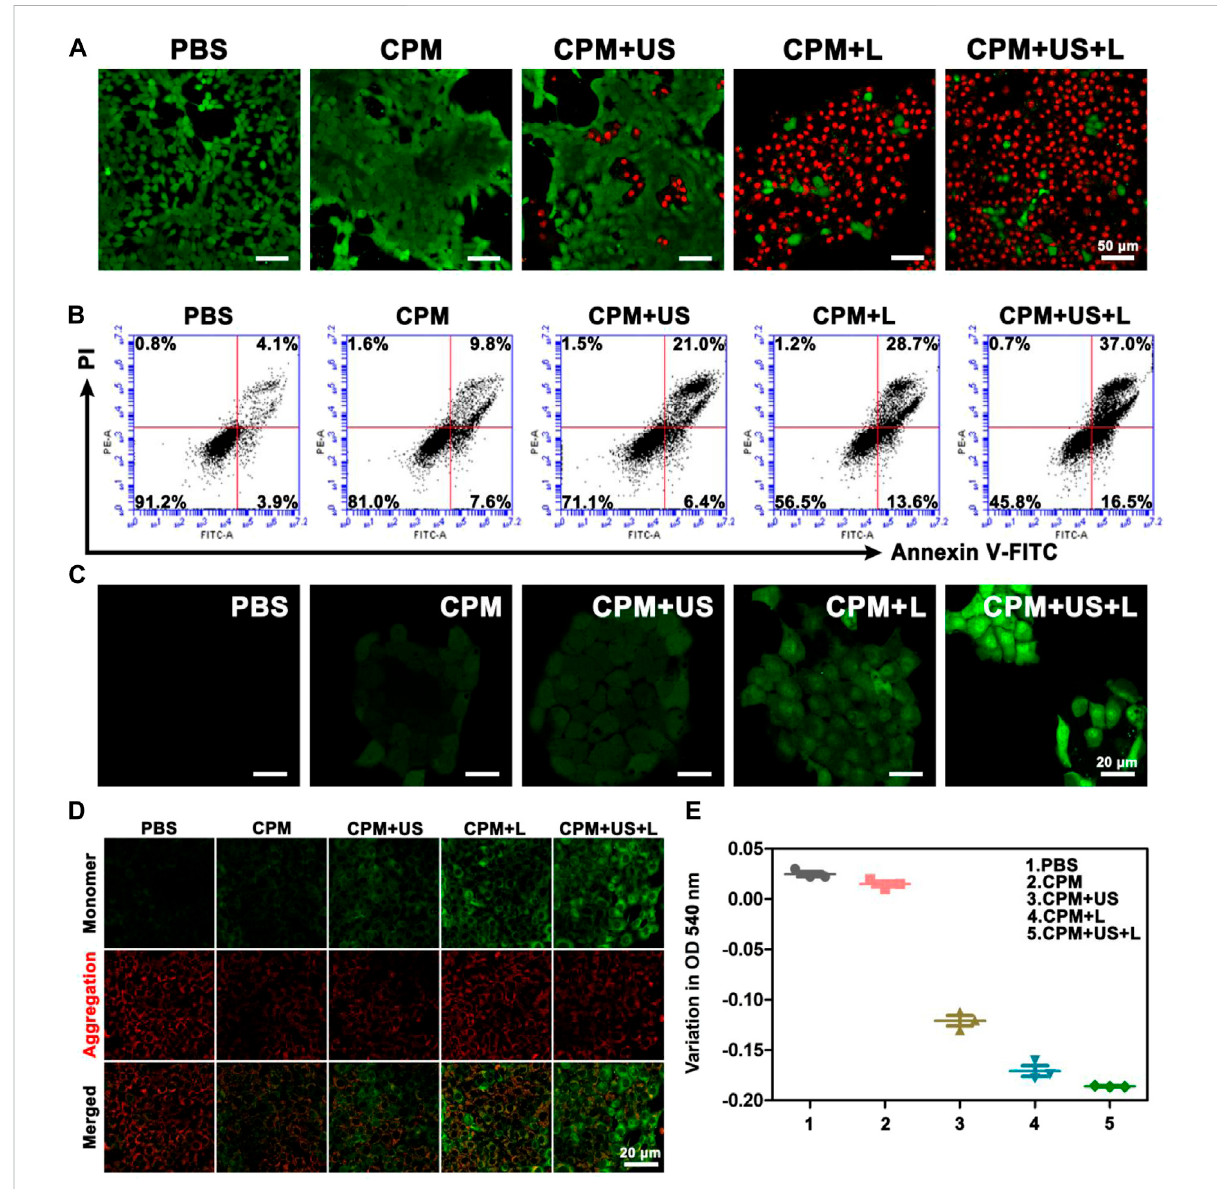
FIGURE 3 (A) Live/deadstainingassay(green,livecells;red,deadcells)and (B) apoptosisanalysisof4T1cellsaftervarioustreatments. (C)